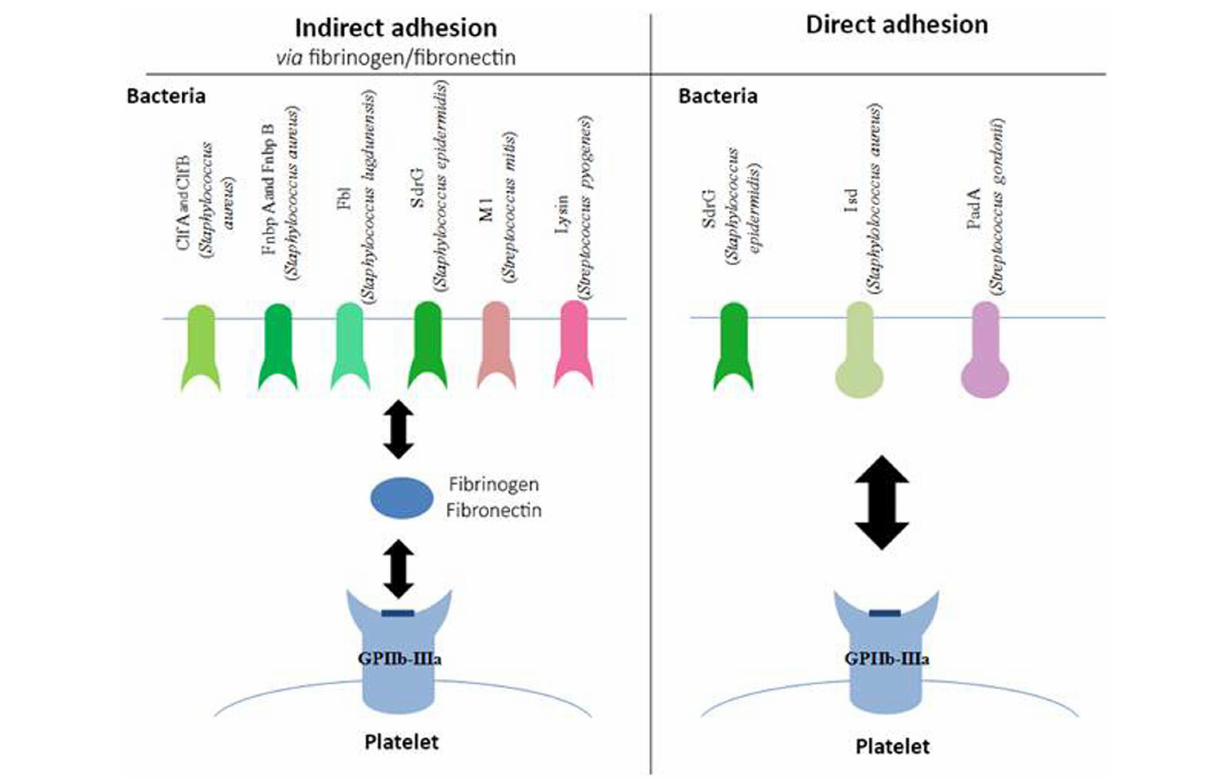
FIGURE 1 | Involvement of GPIIb–IIIa in the adhesion of bacteria to platelets . Schematic representation of different bacterial components, which bind to the platelet GPIIb–IIIa either indirectly via fibrinogen or fibronectin (left